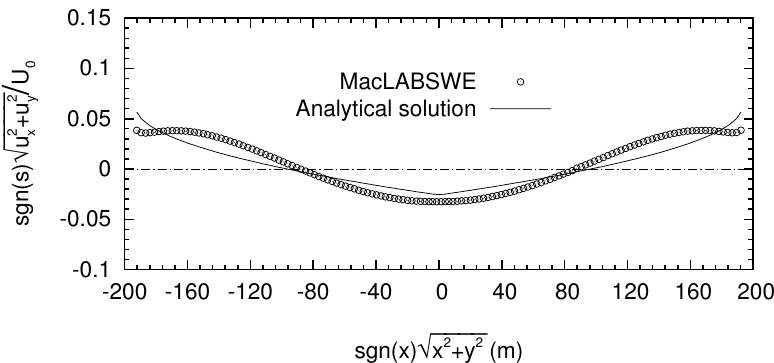
Figure 5. Comparison of the resultant velocities along cross-section A-A (see Figure 4) with the analytical solution [28], where U 0 = 0.129 and s = u x + u y